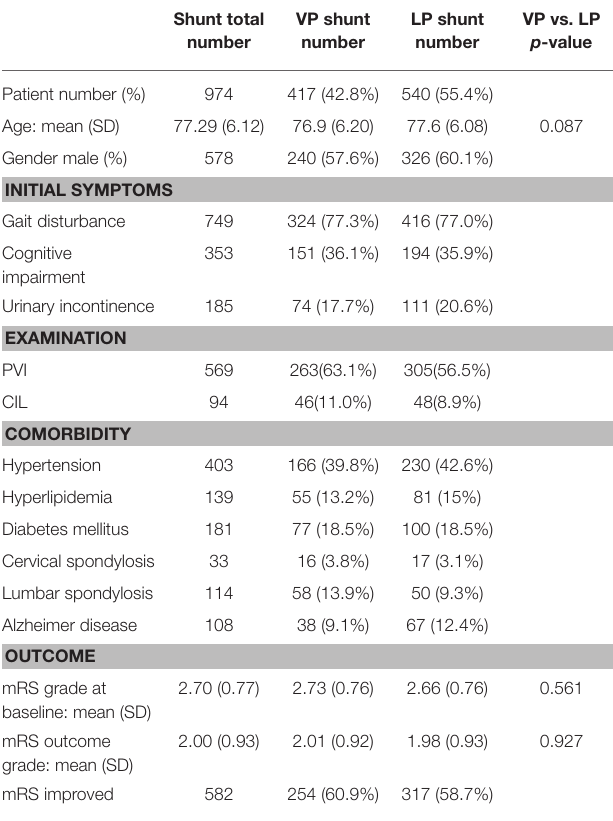
TABLE 2 | Baseline data for shunt intervention method comparison (ventriculoperitoneal shunt vs. lumboperitoneal